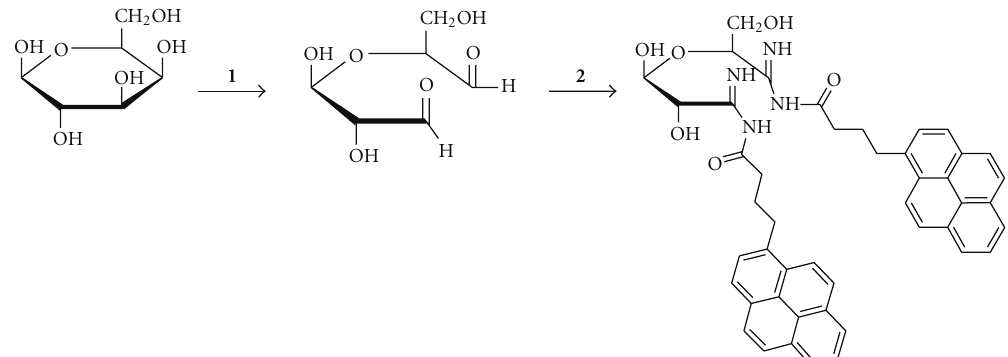
Figure 1: Reactions performed to modify antibody carbohydrates with pyrene hydrazide, illustrated with galactose. Step 1: antibodies are treated with 10mM NaIO 4 , which oxidizes cis-diols to aldehyde groups. Step 2: after a desalting step, the antibody, it is reacted with 1- pyrenebutanoic acid hydrazide which forms stable hydrazone bonds with the formed aldehyde